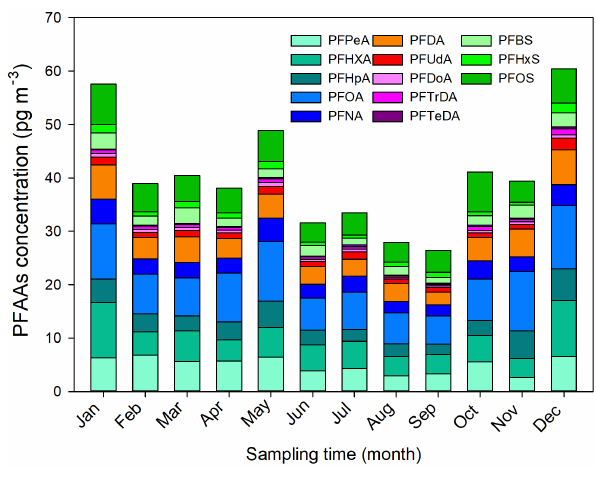
Figure 1. Monthly mean concentrations of PFAAs in China from January to December